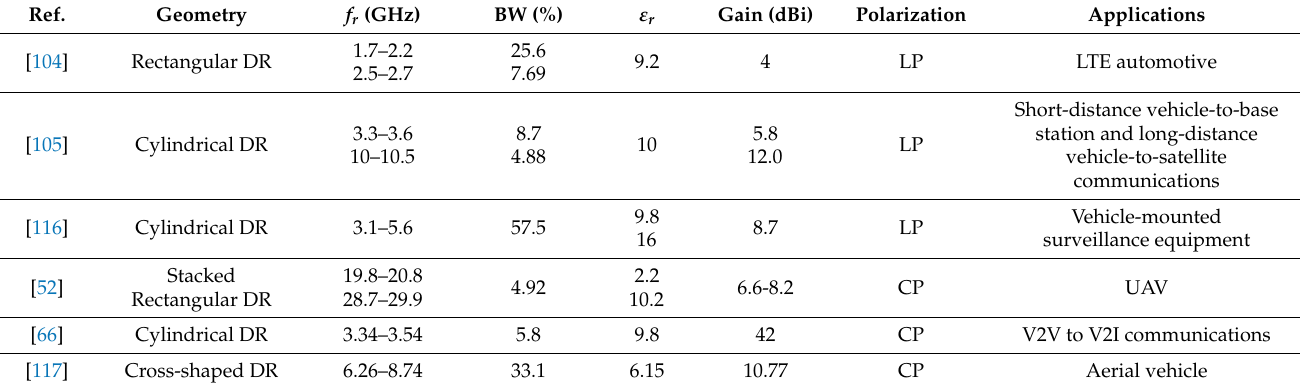
Table 11. Comparison between various DRAs for vehicular applications.